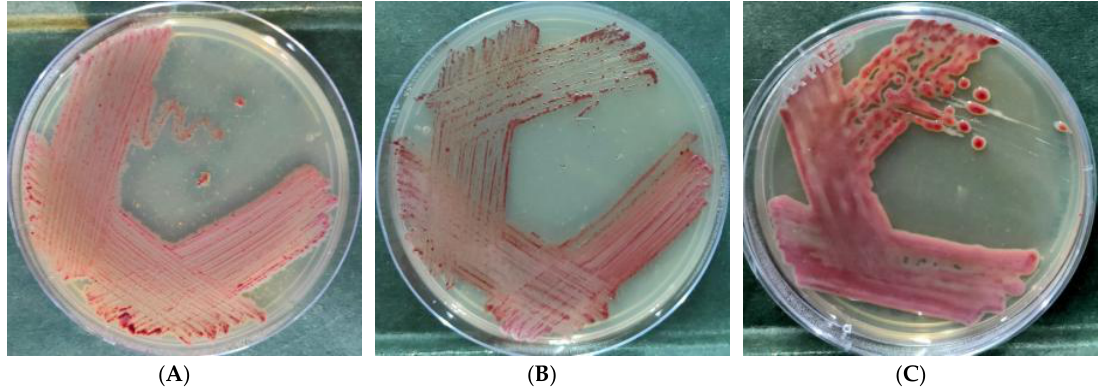
Figure 1. Colony morphology of R. solanacearum NAIMCC-B-01630 used in the study: ( A ) non-fluidal, ( B ) butyrous, and ( C ) fluidal colonies.